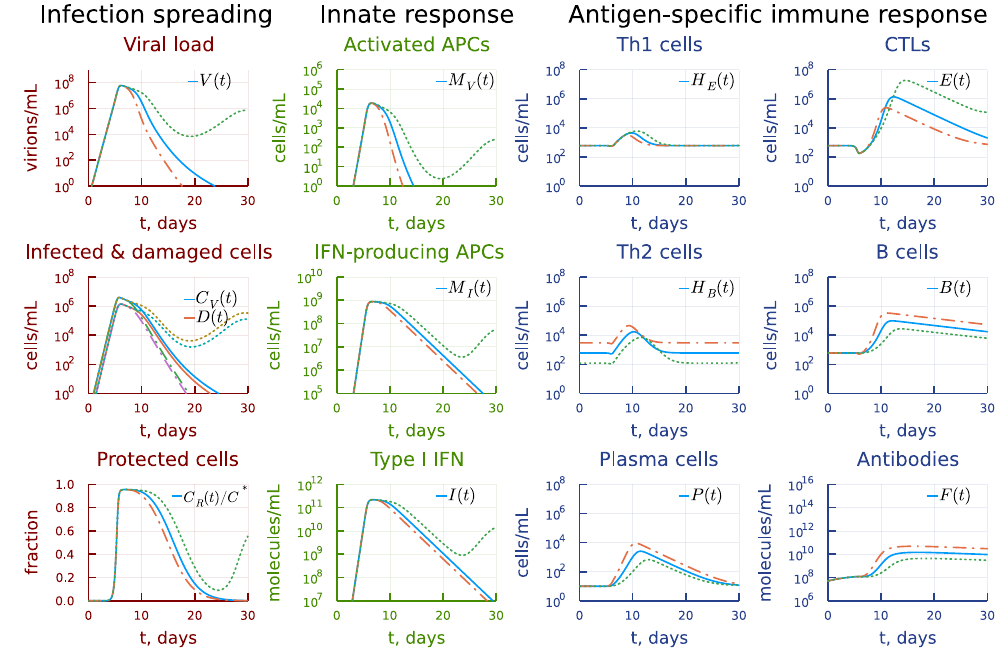
Figure 15. Effect of the activation rate constant of Th2 cells. Dashdot: 10-fold increase of b B 10-fold decrease of b B relative to baseline value. H